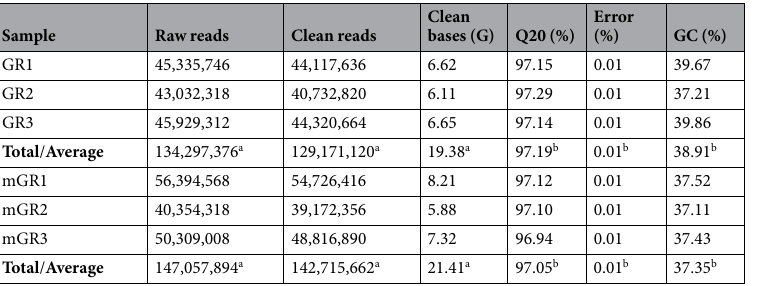
Table 1. Quality of sequencing. a Total number of data from the three samples. b Average number of data from the three samples.